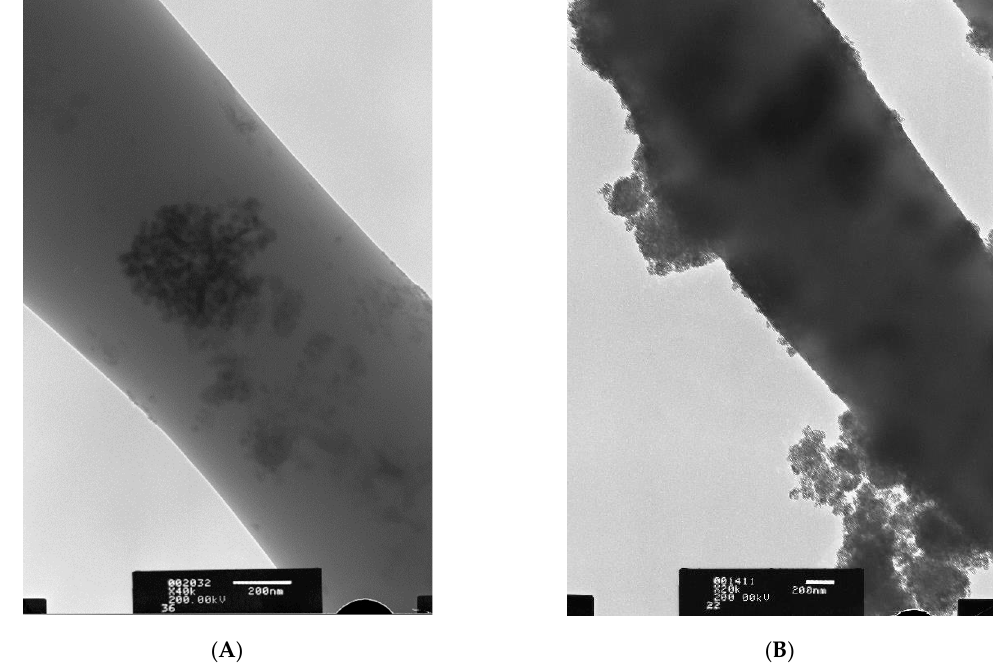
Figure 4. TEM images of fibers: ( A ) TiO 2 - in -PHB and ( B ) TiO 2 - on -PHB.